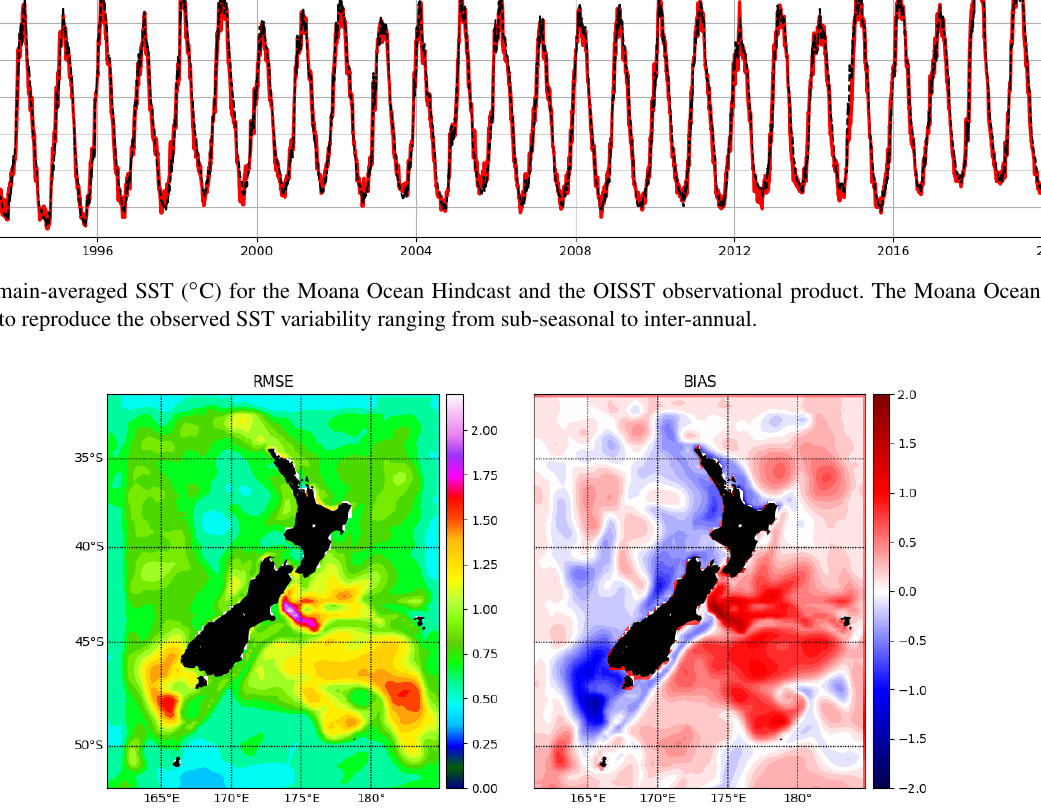
Figure 6. RMSE and BIAS of the Moana Ocean Hindcast SST ( ◦ C) in comparison to the OISST observational product. It shows that differences between the simulation results and the OISST are concentrated in the locations of strong fronts and the coast. These relate to the fact that this is a free-running simulation, differences in resolution and the inability of the observational product to represent temperatures close to the shoreline. Table 3 were calculated using the below